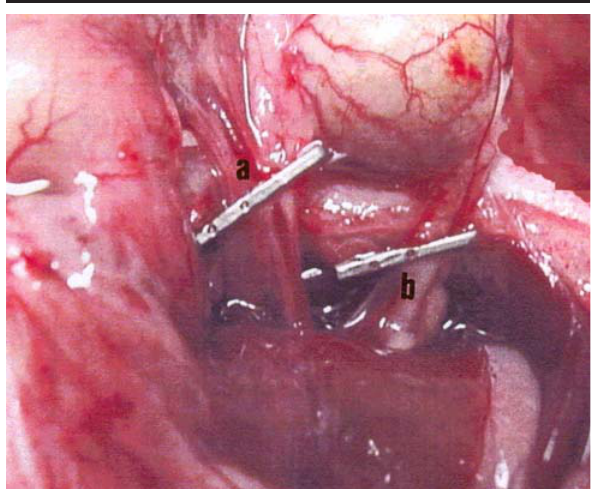
FIGURA 3 – Fotografia mostrando o clipe de titânio aplicado na artéria e veia gástrica esquerda (a) e nos vasos gástricos curtos (b).